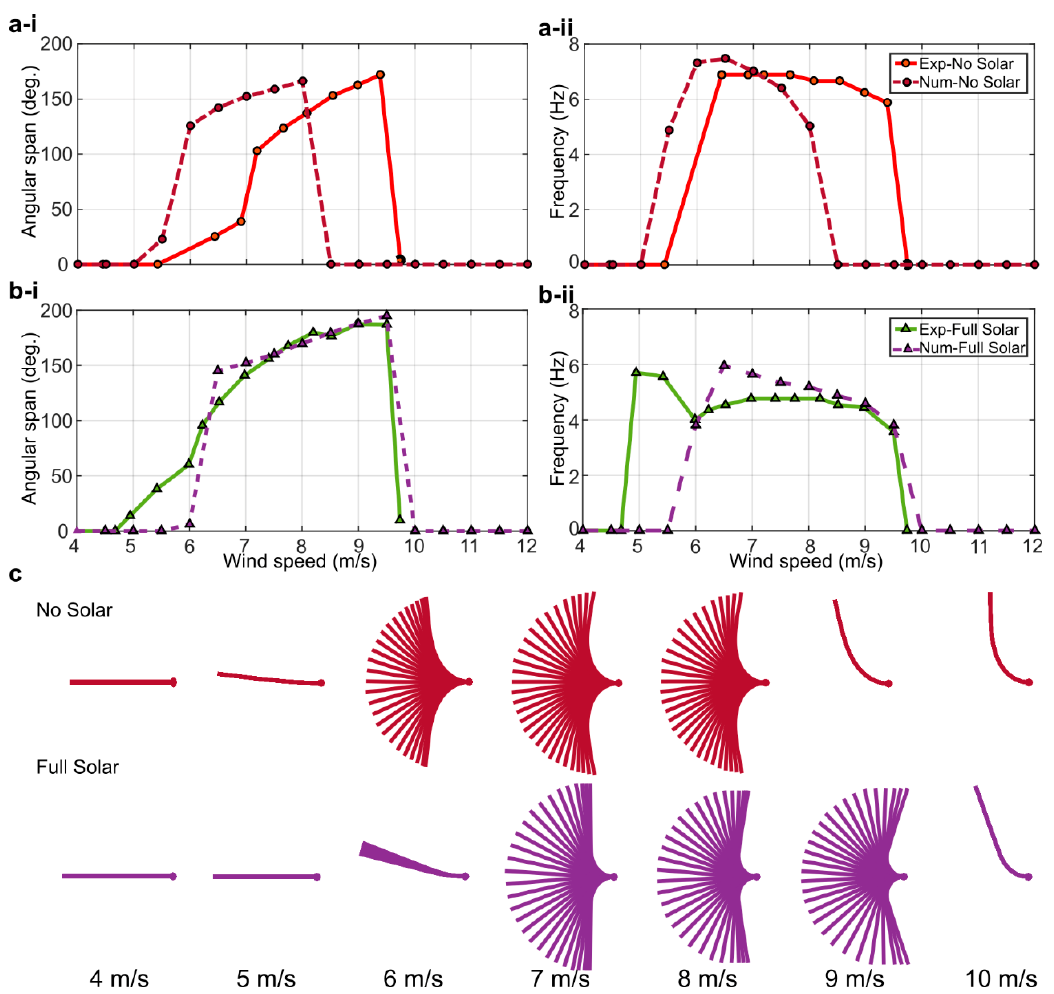
Figure 9. Comparison of the numerical solver simulation results with experimental measurements: ( a ) no-solar flag; ( b ) full-solar flag. ( i ) Angular span of motion vs. wind speed; ( ii ) dominant frequency vs. wind speed; ( c ) envelopes of motion from the numerical simulations at various wind speeds.